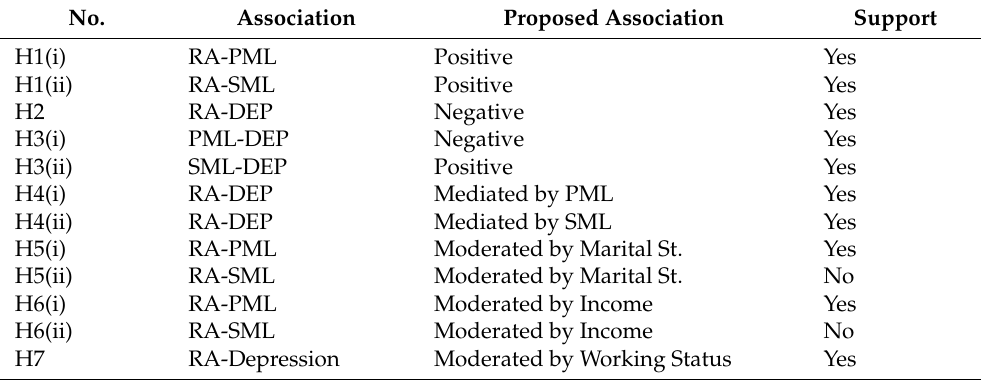
Table 6. Test results of